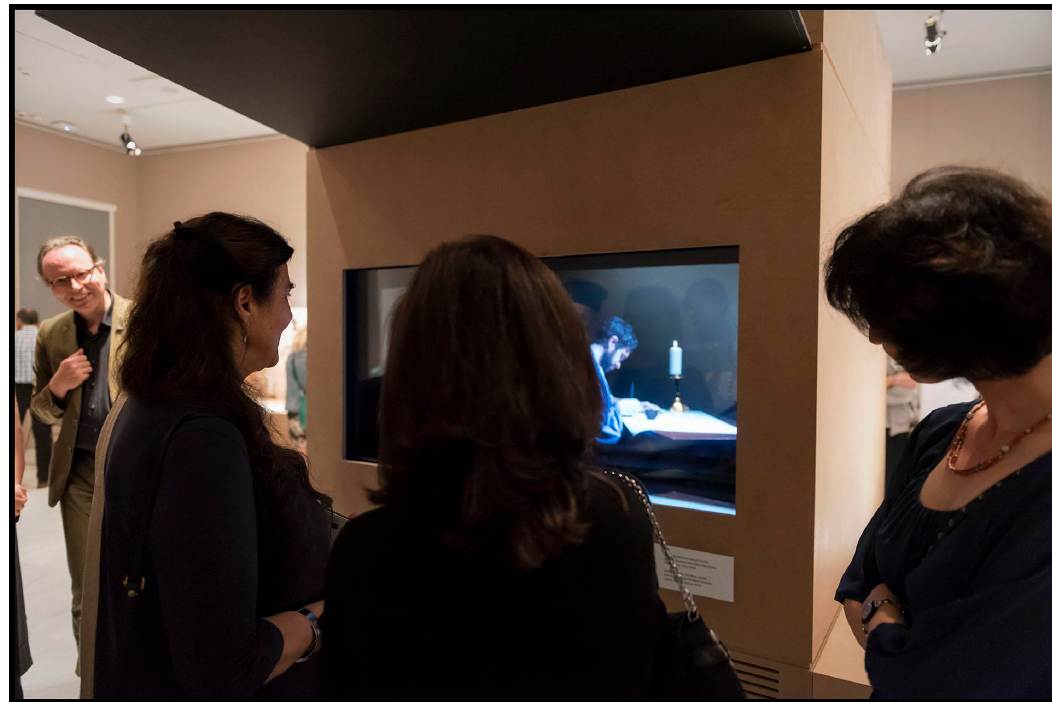
Figure 7. Holographic showcase using Pepper’s Ghost effect created by CNR and E.V.O.CA. srl (Rome). Here presented at the Byzantine and Christian Museum of Athens, 2017–2018.